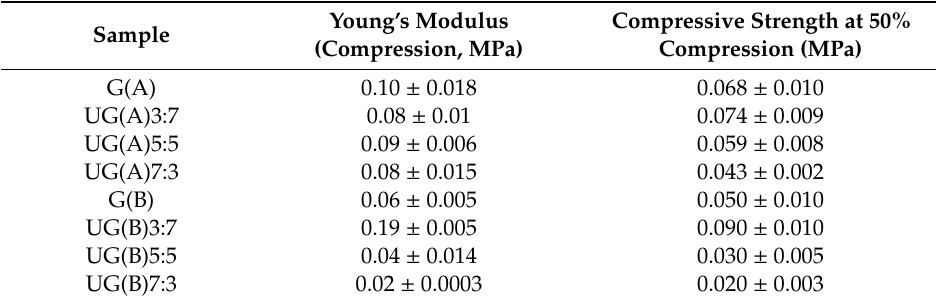
Table 2. Young’s modulus and compressive strength at 50% compression for UG sca ff olds Young’s Modulus Compressive Strength at 50% Sample (Compression, MPa) Compression